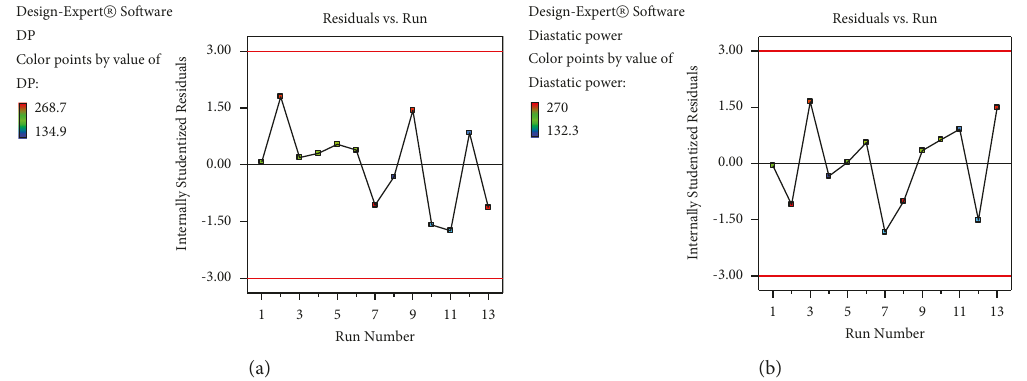
Figure 7: Residuals vs run plot for diastatic power in the malting process for (a) quinoa and (b) barley. Table 8: Optimisation of the malting conditions of barley and quinoa grains.